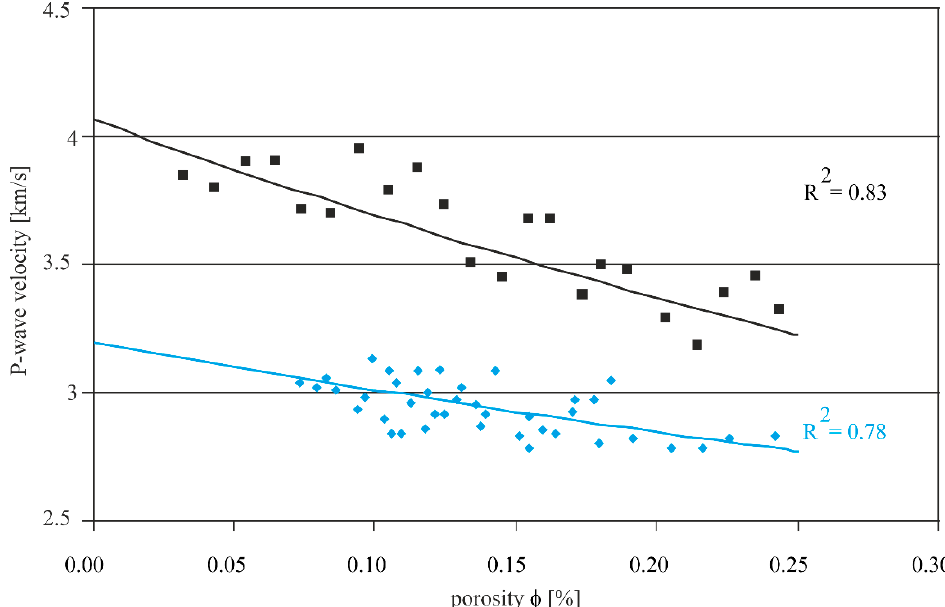
Figure 4. P-wave velocity as a function of porosity for the carbonate deposit calculated based on the Wyllie model. The black line represents the velocity estimator for massive limestone, and the blue line represents the velocity estimator for marly limestone. Both are overlaid with real values of velocity measured by well logging.